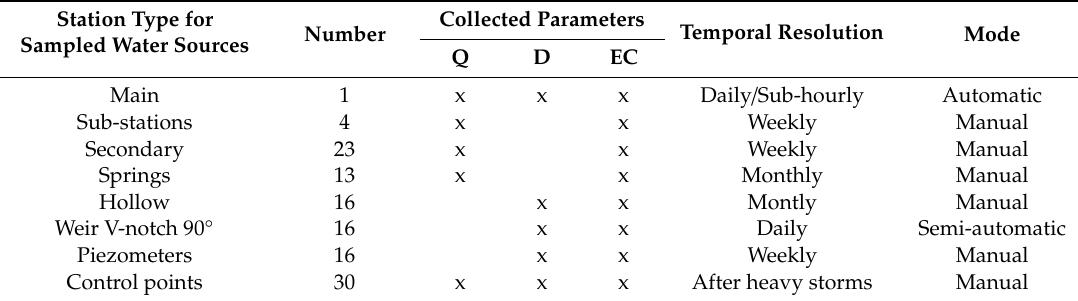
Table 2. Summary of the monitored points with the collected parameters and time-steps. D: water depth; Q: discharge; EC: electrical conductivity (modified from [8]).